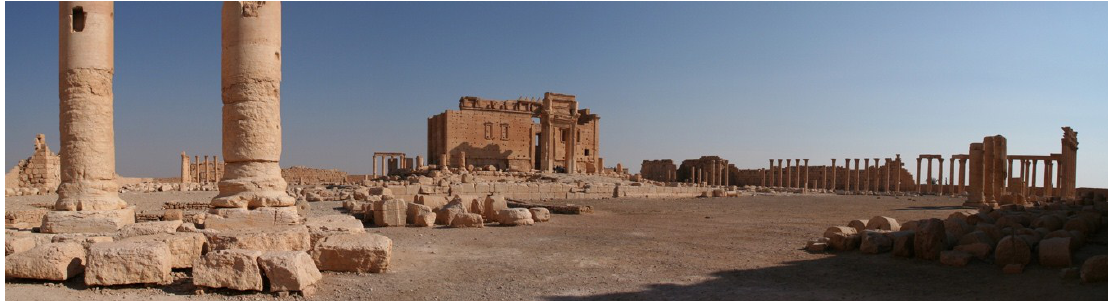
Figure 4. The Temple of Bel, Palmyra, Syria, in December 2008, prior to its destruction by Da’esh in August 2015.